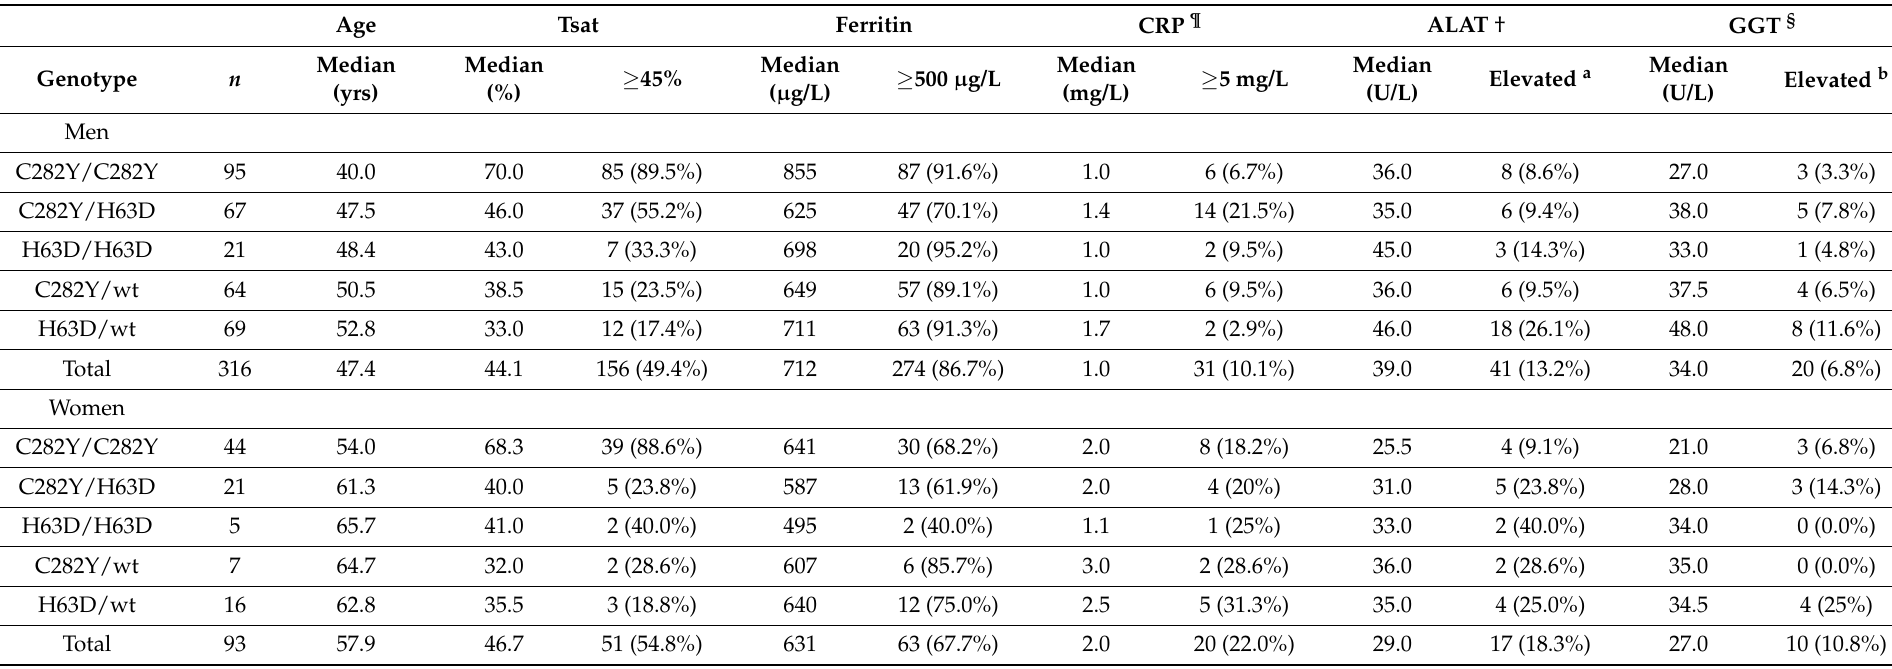
Table 4. Age and biochemical findings in relation to